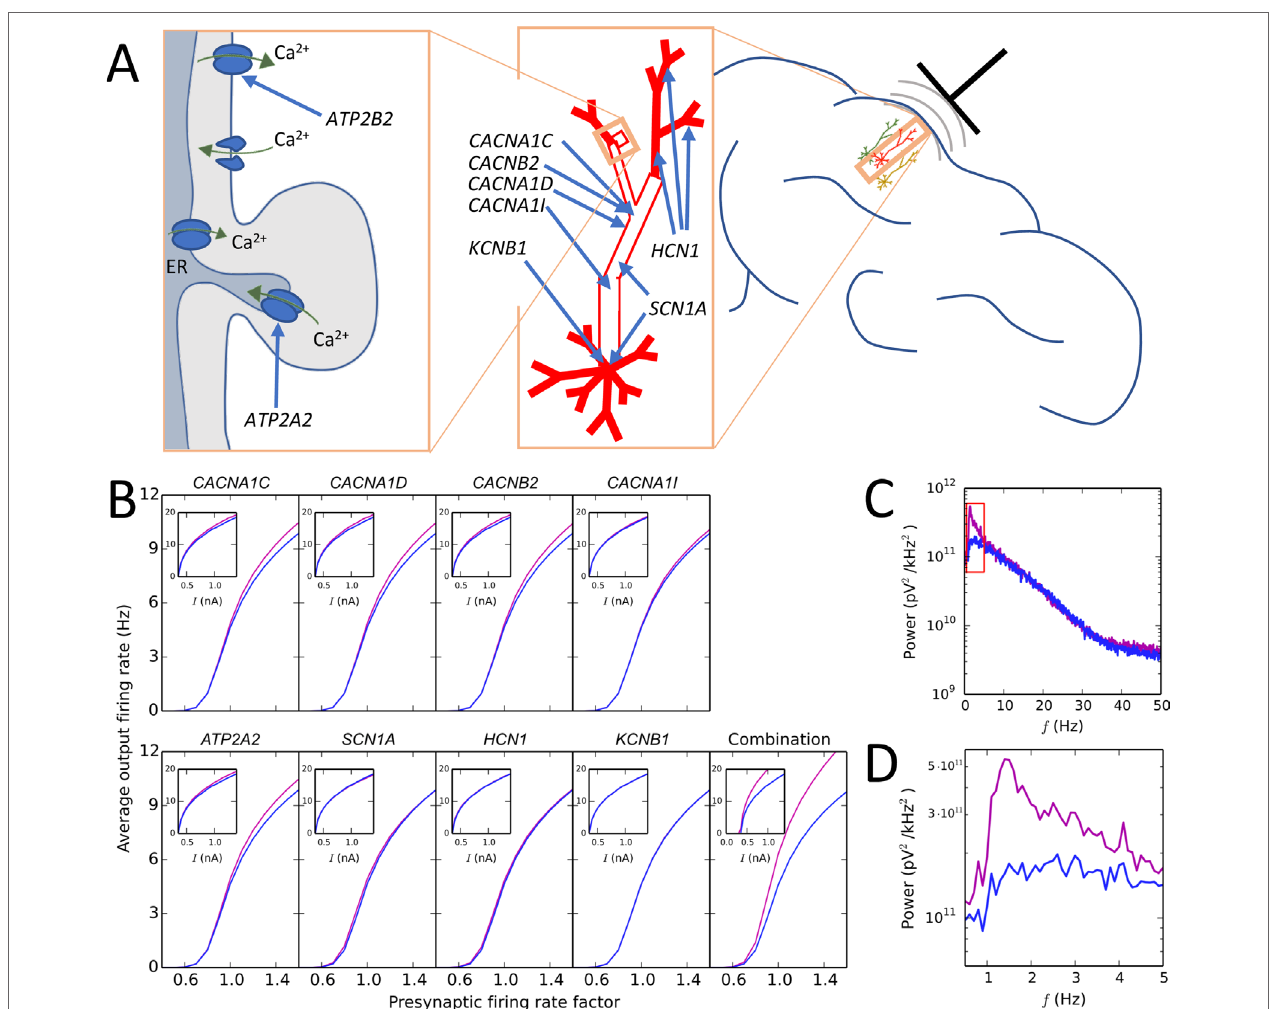
FIGURE 2 | Illustration of a modelling approach predicting that a combination of small-effect variants in different schizophrenia-associated ion channel- and Ca 2+ transporter-encoding genes causes large effects on the delta band in the EEG power spectrum. (A) Schematic illustration of the subcellular domain (left) of a layer V pyramidal cell (middle) and the localization of the neuron with respect to a recording electrode (right). Genes ATP2A2 and ATP2B2 contribute to the Ca 2+ dynamics of the neuron: ATP2A2 encodes a subunit of the sarco/endoplasmic reticulum Ca 2+ -ATPase (SERCA) that pumps cytosolic Ca 2+ into the endoplasmic reticulum (ER), and ATP2B2 encodes a subunit of the plasma membrane Ca 2+ ATPase (PMCA) that expels cytosolic Ca 2+ to the extracellular medium. Genes CACNA1C , CACNA1D , and CACNB2 encode subunits of high-voltage activated Ca 2+ channels, and CACNA1I encodes a low-voltage activated Ca 2+ channel: these channels are densely expressed in the “hot zone” of Ca 2+ channels at the apical dendrite, but they are present in the soma as well (68). SCN1A encodes a subunit of the fast voltage-gated Na + channel that is densely expressed in the soma and mildly expressed in the apical dendrite (68). Finally, KCNB1 encodes a subunit of a voltage- gated K + channel that is only present in the soma, and HCN1 encodes a subunit of a non-specific cationic channel whose density grows toward the end of the apical dendrite (68). (B) Effects of model variants of schizophrenia-associated ion channel- and Ca 2+ transporter-encoding genes on firing rates of layer V pyramidal neurons as part of a network (main curves) and in isolation (insets). In the network experiments, interconnected networks of 150 neurons were simulated for 11 s so that the rate of presynaptic inputs (AMPA, NMDA, and GABA receptor-mediated currents) was controlled by factor (shown on x -axis), which influenced the average firing rate of the neurons in the network (shown on y -axis). In the single-cell experiments, a prolonged somatic square-pulse current (amplitude shown on x -axis) was given at the soma, affecting the firing frequency (shown on y -axis). The blue curves show the control network/neuron, while the purple curves show the network/ neuron with the model variant. The fifth subpanel in the bottom row shows the effects of combination of the eight variants. For network simulations, reduced- morphology representations (48) of the layer V pyramidal cells were used to avoid excessive simulation load. Adapted from Mäki-Marttunen et al. (93). (C) Power spectrum of the EEG signal predicted from the activity of the network corresponding to presynaptic rate factor 1.0 in control and variant-combination conditions of panel (B) . To obtain this signal, transmembrane currents were registered at each compartment of each cell, and these currents were used to calculate the dipole moment time series of the cell population. From the dipole moments, the EEG signal was estimated using a theoretical model of Næss et al. (153), implemented in the LFPy Python package (141). Consistent with the predictions of panel (B) , the EEG power is increased for the combination of model variants compared with the control network, especially in the delta (0.5–5 Hz) range. Adapted from Mäki-Marttunen et al. (93). (D) Zoomed-in view on the red rectangle of panel (B)